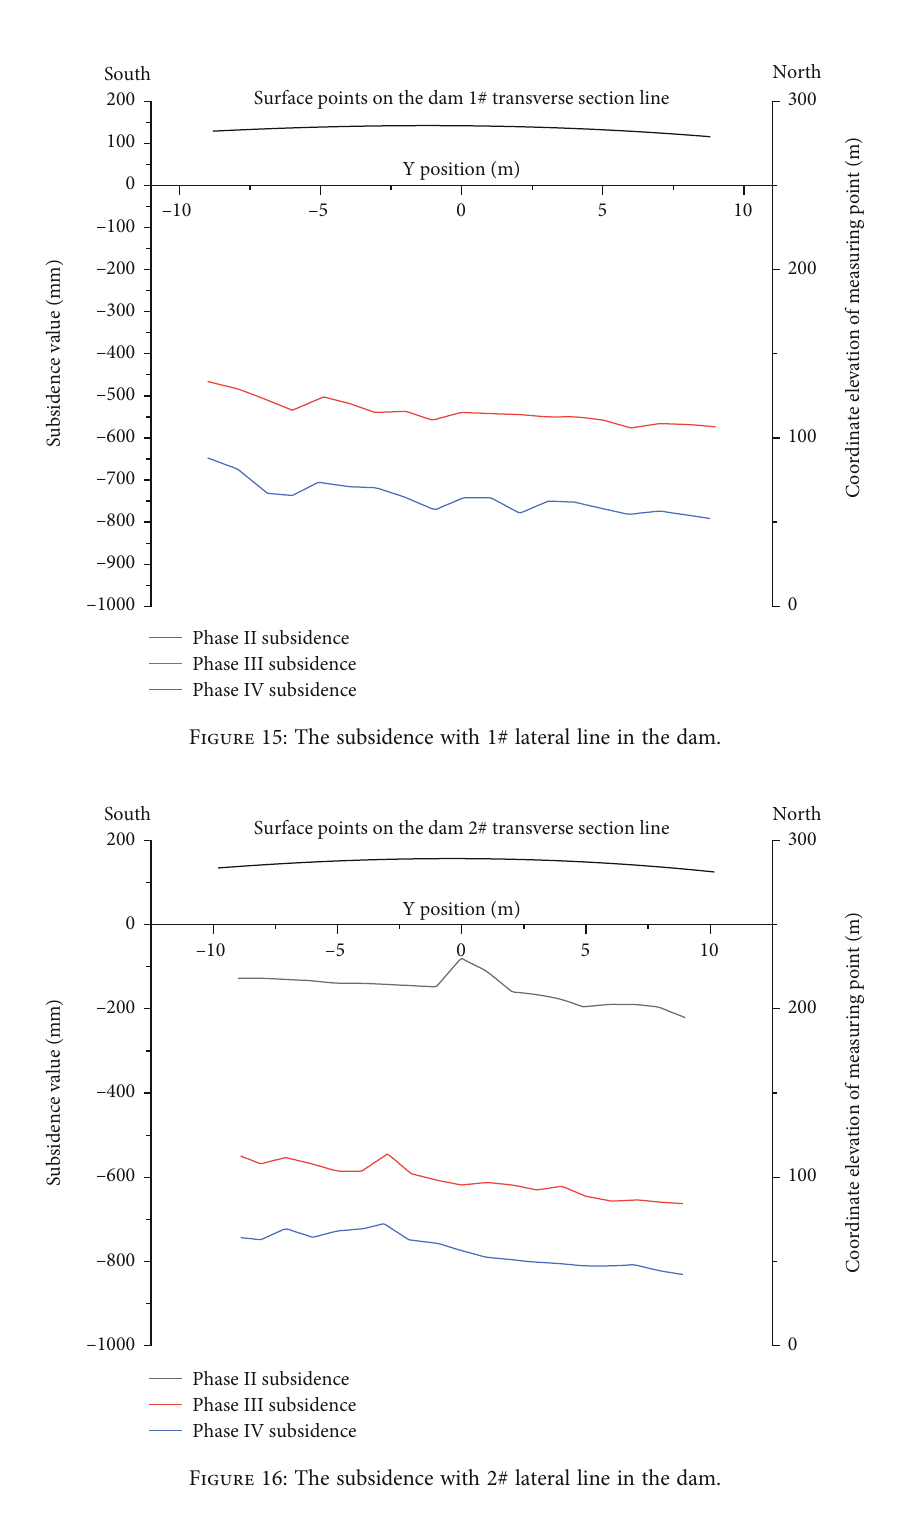
Figure 16: The subsidence with 2# lateral line in the